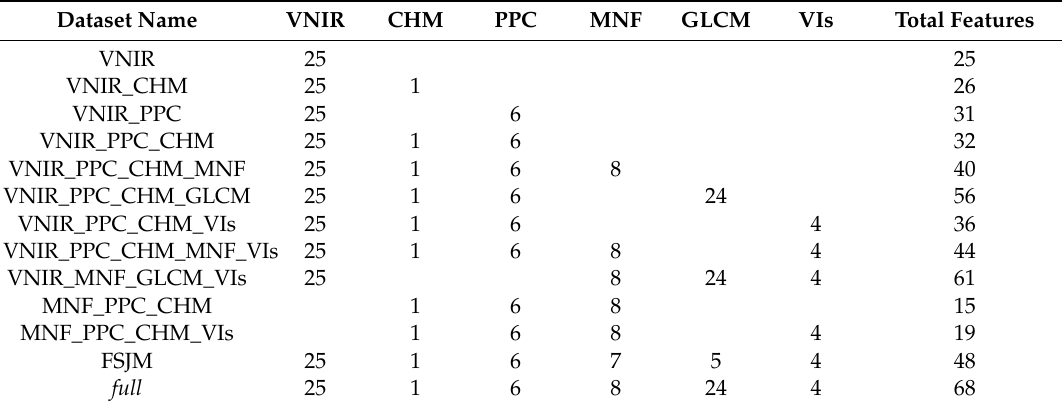
Table 6. Classification experiments according to the features used in the classification